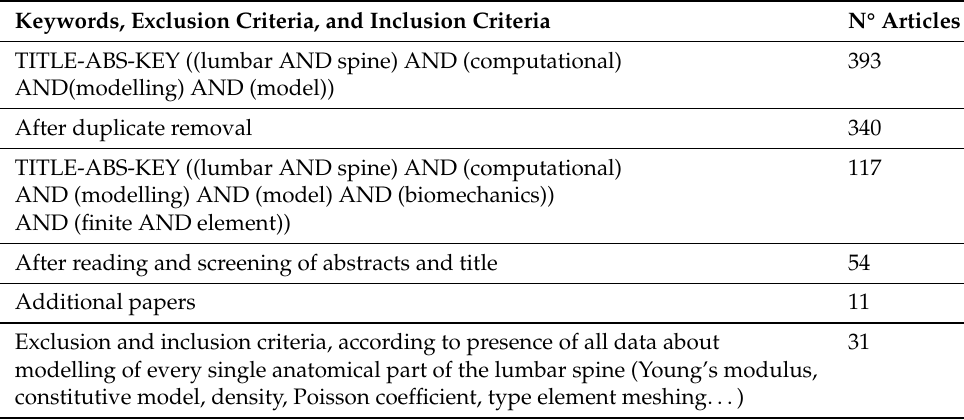
Table 1. Keywords, inclusion criteria, and exclusion criteria.